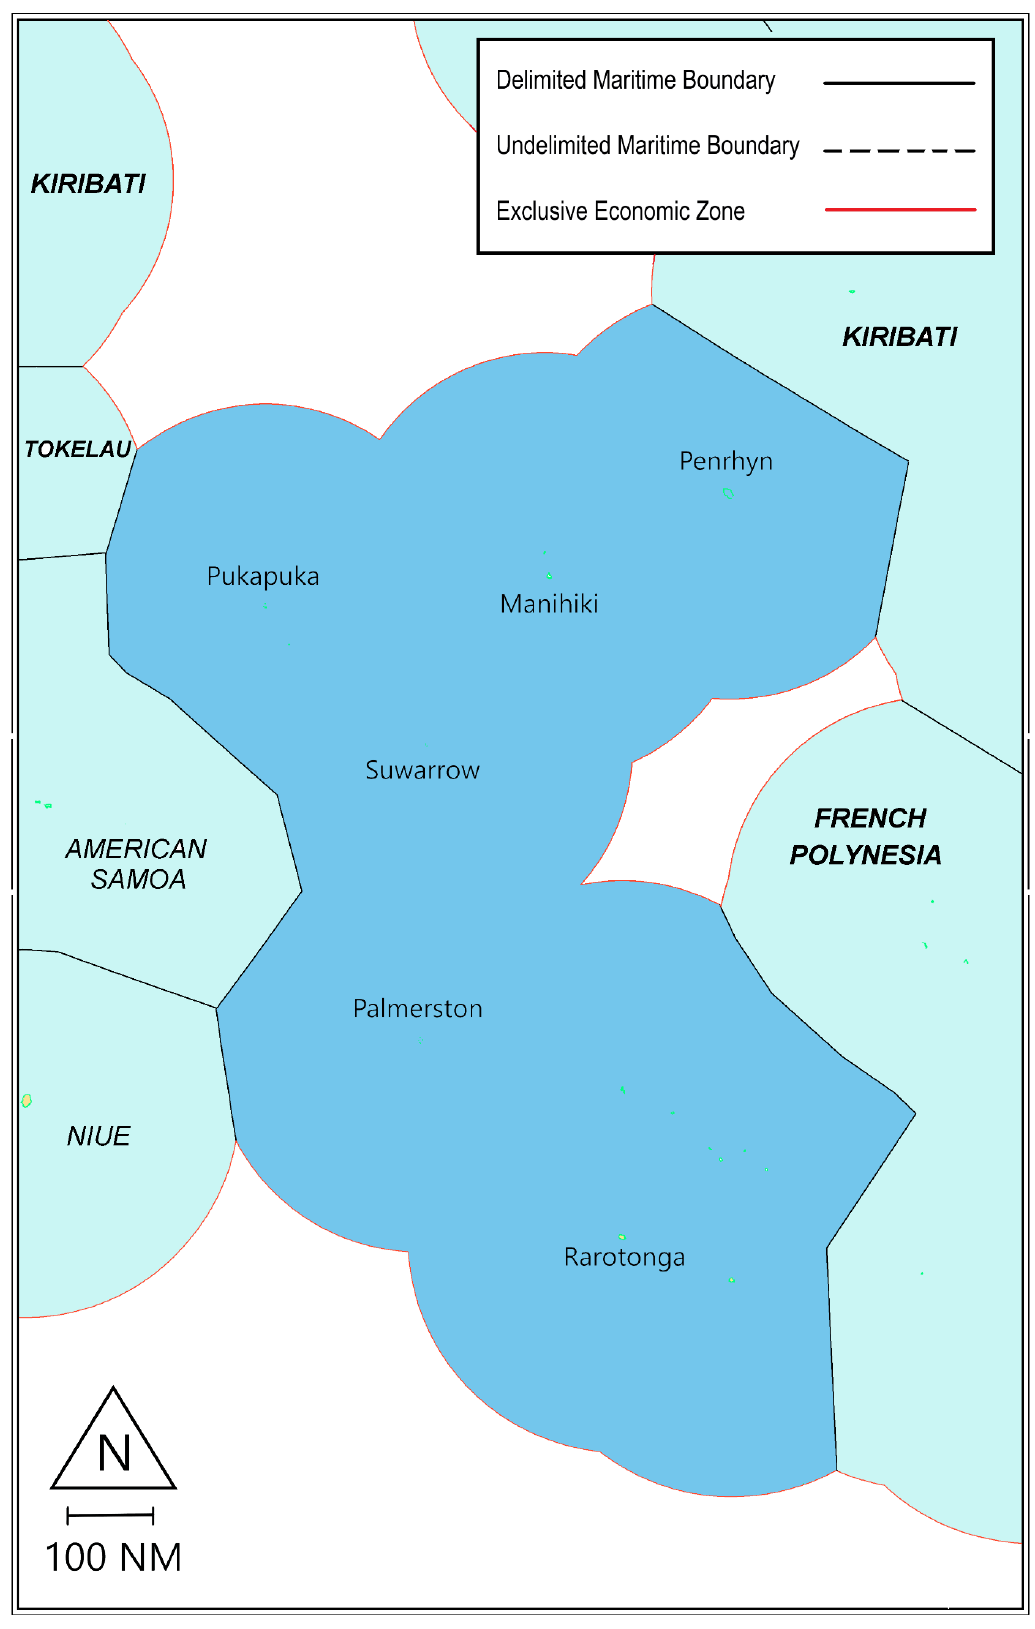
Figure 10. Cook Islands’ claimed EEZ areas and boundaries.